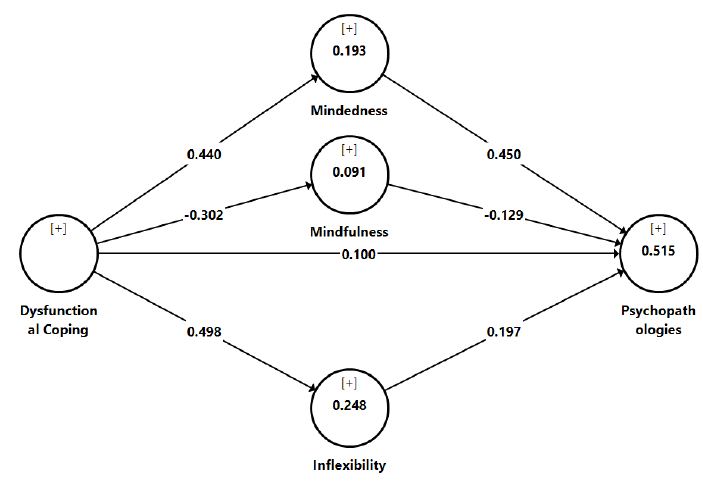
Figure 1. Results of structural model.